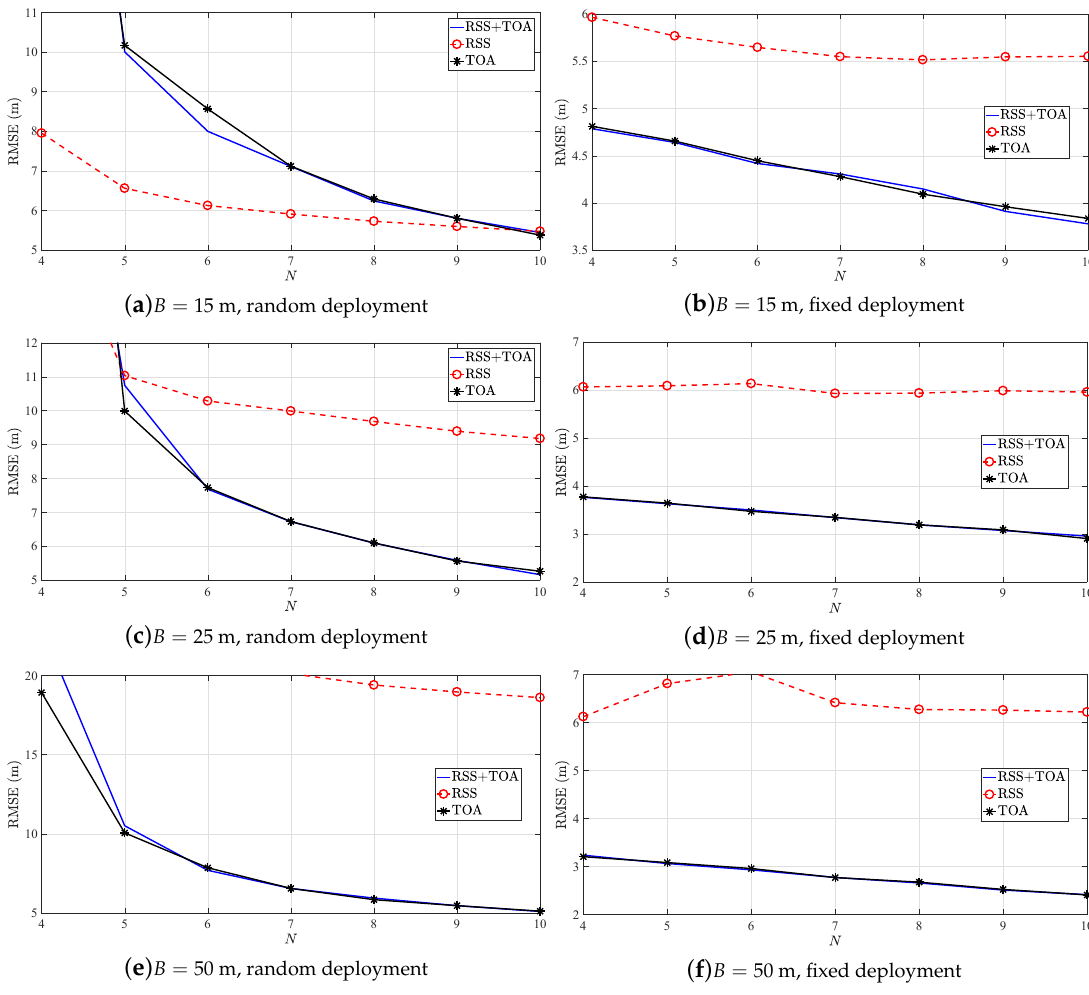
Figure 4. RMSE versus N comparison for